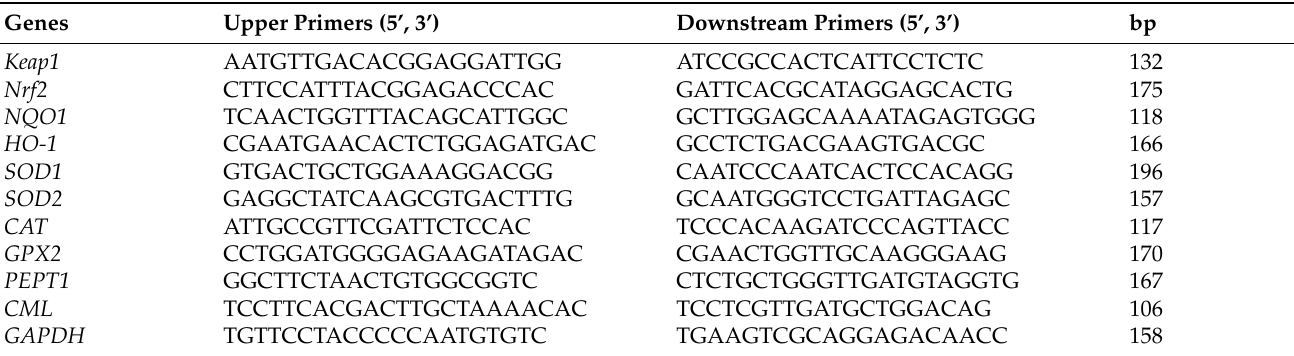
Table 3. Synthesis sequence of qRT-PCR